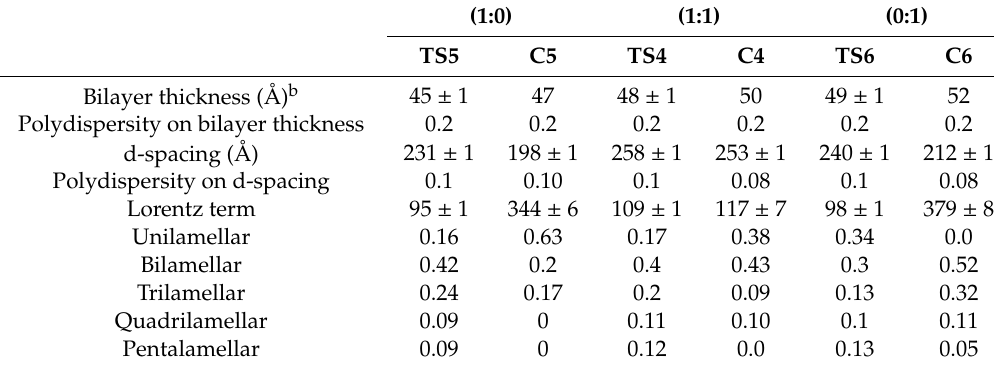
Table 4. Model fitted parameters for the SANS profiles at 318 K of ternary systems (TS4–TS6) a and creams (C4–C6) containing 10% w / w emulsifier concentration and either a 1:1, 1:0 or 0:1 ratio of hexadecanol:octadecanol